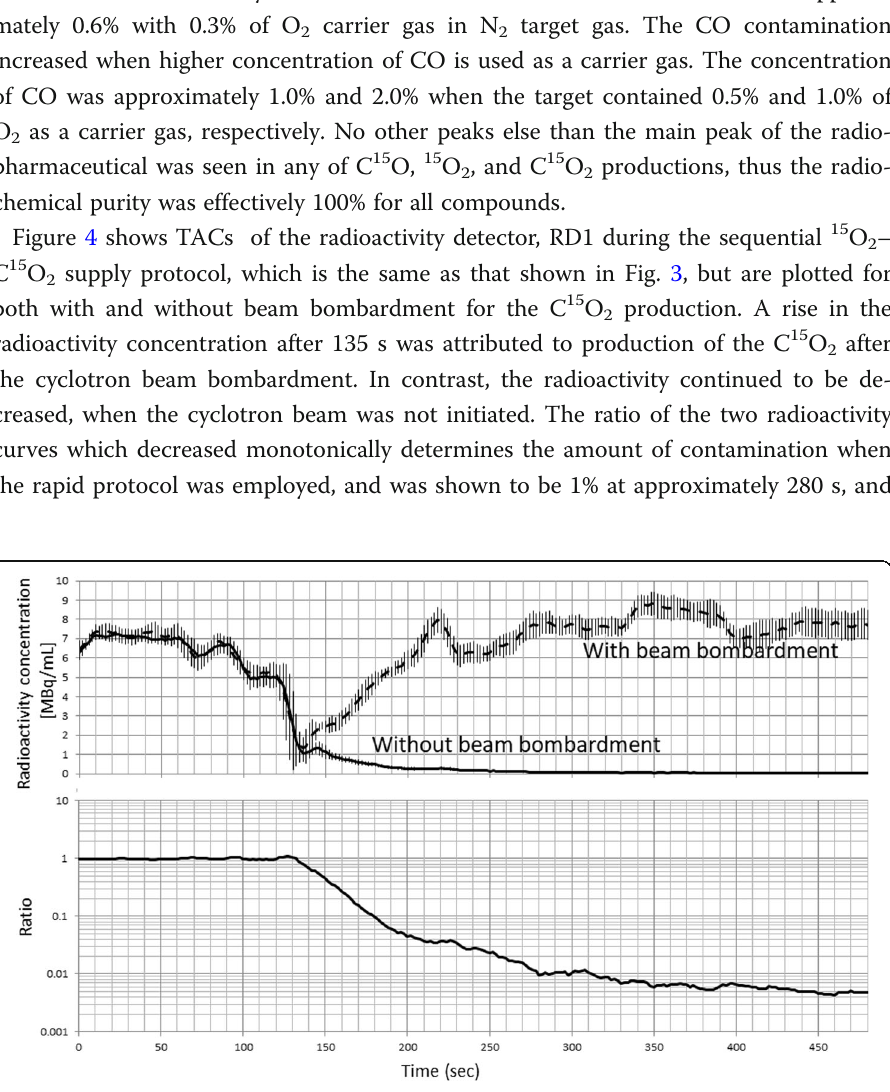
15 O-production